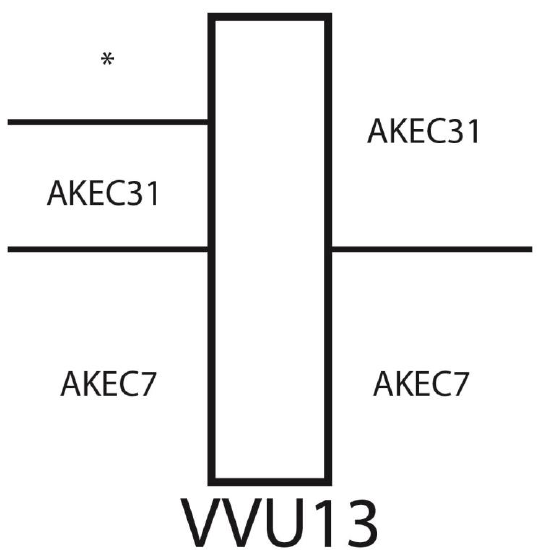
Figure A2. Proposed updates to the Ancestral Karyotype of Extant Canids (AKEC) [39]. Asterisks denote regions of the fox chromosomes where the ancestral chromosome number was unknown in [39]. The original AKEC underestimates the coverage of VVU4 and VVU13 by the previously identified homologous ancestral chromosomes. The results of comparative genome mapping support a simpler homology between the ancestral chromosomes and the modern vulpine chromosomes, as indicated to the